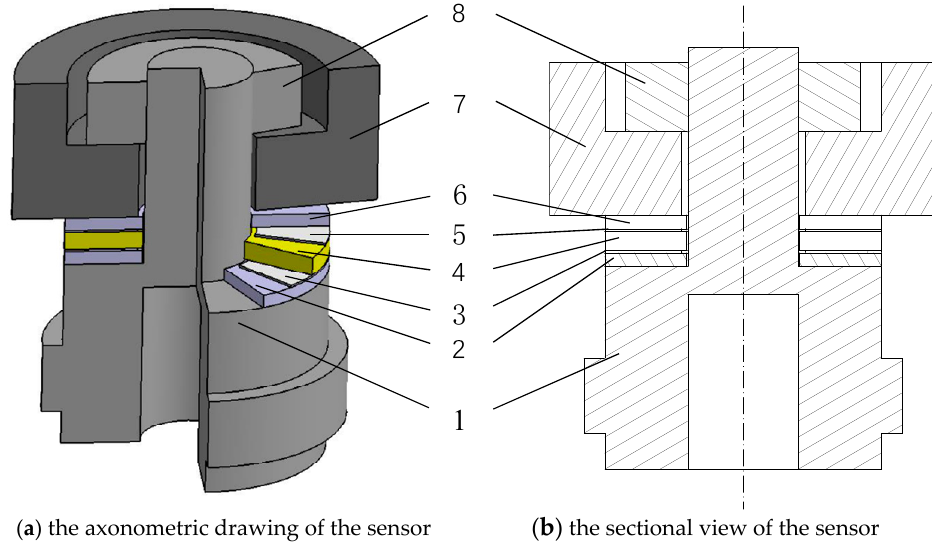
Figure 1. Schematic diagram of sensor structure.